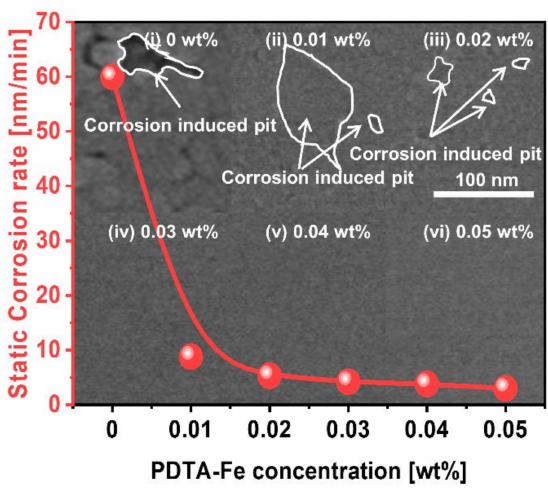
Figure 3. Dependency of static etch rate (SER) of Ge 1 Sb 4 Te 5 film surface on ferric–ionic catalyst (i.e., PDTA–Fe) concentration after dipping of Ge 1 Sb 4 Te 5 film surface into slurries. The background SEM images investigated the presence of corrosion-induced pits on the Ge 1 Sb 4 Te 5 film surface after dipping.